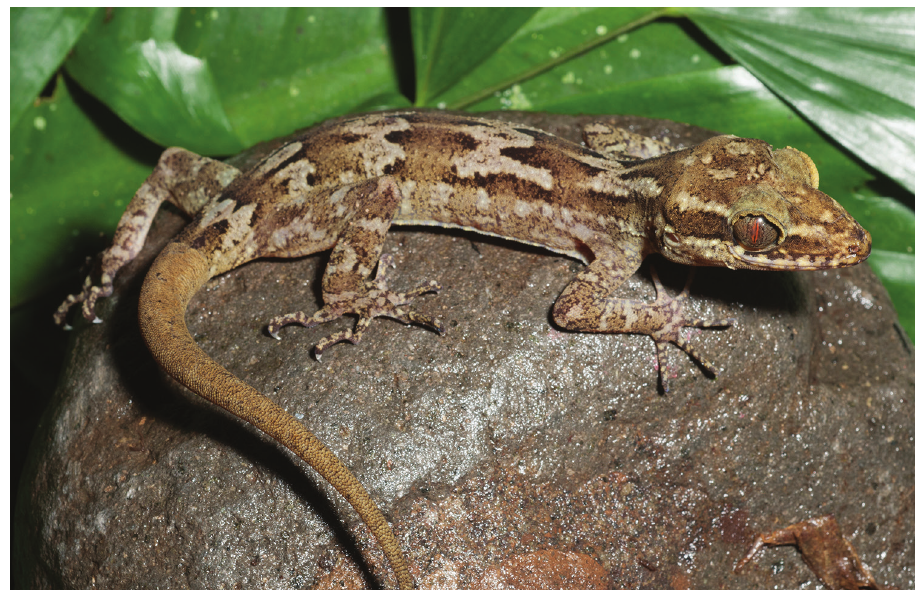
Figure 46. Cyrtodactylus agusanensis male (KU 334046) from Eye Falls, Mt. Hilong-hilong, Municipality of Remedios T. Romualdez, Agusan del Norte Province. Photo: